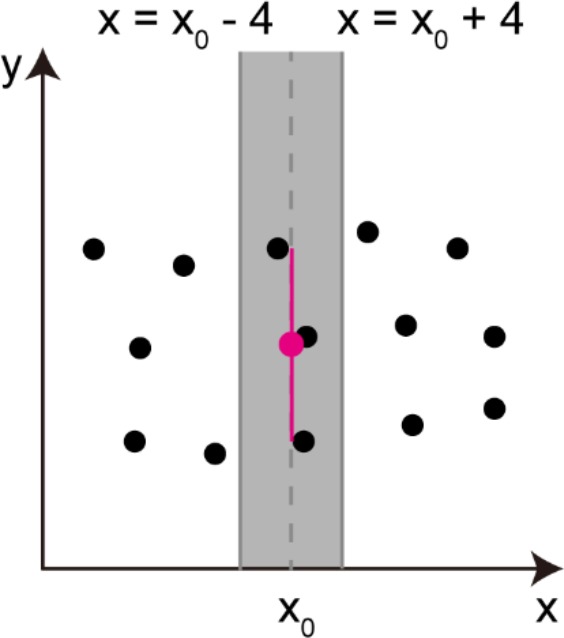
Procedures of obtaining parameters necessary for radial alignment (along y-axis) of cell centers.Calculation of an averaged y position of the cell group (a red circle) and a vertical spread of the cell group (a red vertical line). These two parameters were calculated in the area (colored in gray) containing more than two ‘cell centers’. Black dots indicate the positions of ‘cell centers’, and the variable x0 indicates the x-coordinate of the averaged cell center within the gray area.